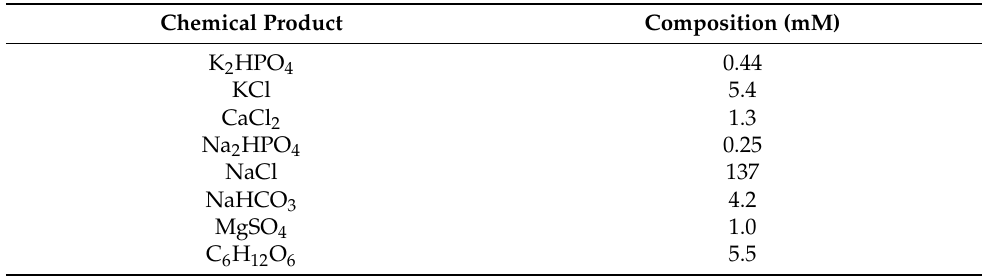
Table 1. Chemical composition of Hank’s